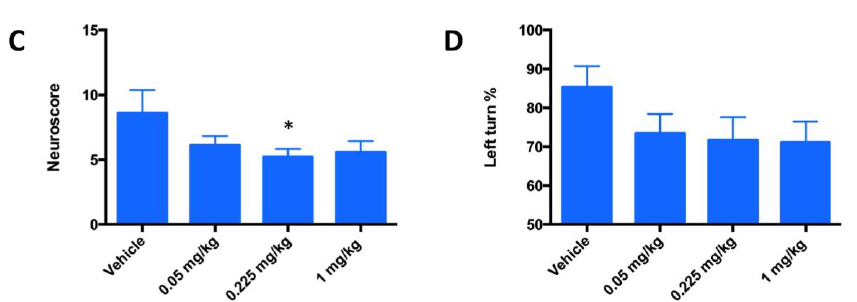
Figure 7. Evaluation of the neurologic deficit in a 3-day mouse MCAO stroke model in terms of motor neuron activities. Mice ( n = 20) underwent a 90-min occlusion. FeHex was given IV via the tail vein at three different doses starting at 90 min post ischemia/reperfusion and continued twice daily for 3 days. ( A ) Body weights are expressed as body weight at 3 days post-stroke - body weight at surgery day; ( B ) rotarod performance, data are presented in % and are calculated as [(reading after injury)/(reading before surgery-baseline reading)] × 100; ( C ) neuroscore; and ( D ) Corner test. Vehicle vs 0.225 mg/kg, p = 0.0347 for body weight change ( A ); p = 0.59 for rotarod ( B ); p = 0.047 for neuroscore ( C ); and p = 0.09 for Corner test (0.225 mg/kg), and p = 0.0725 for Corner test (1 mg/kg) ( D ). For all other concentrations vs vehicle, p > 0.05; i.e. no significance was achieved. The “star” (*) symbol denotes statistically significant di ff erence relative to the vehicle group ( p < 0.05). Antioxidants 2020 , 9 , x FOR PEER REVIEW